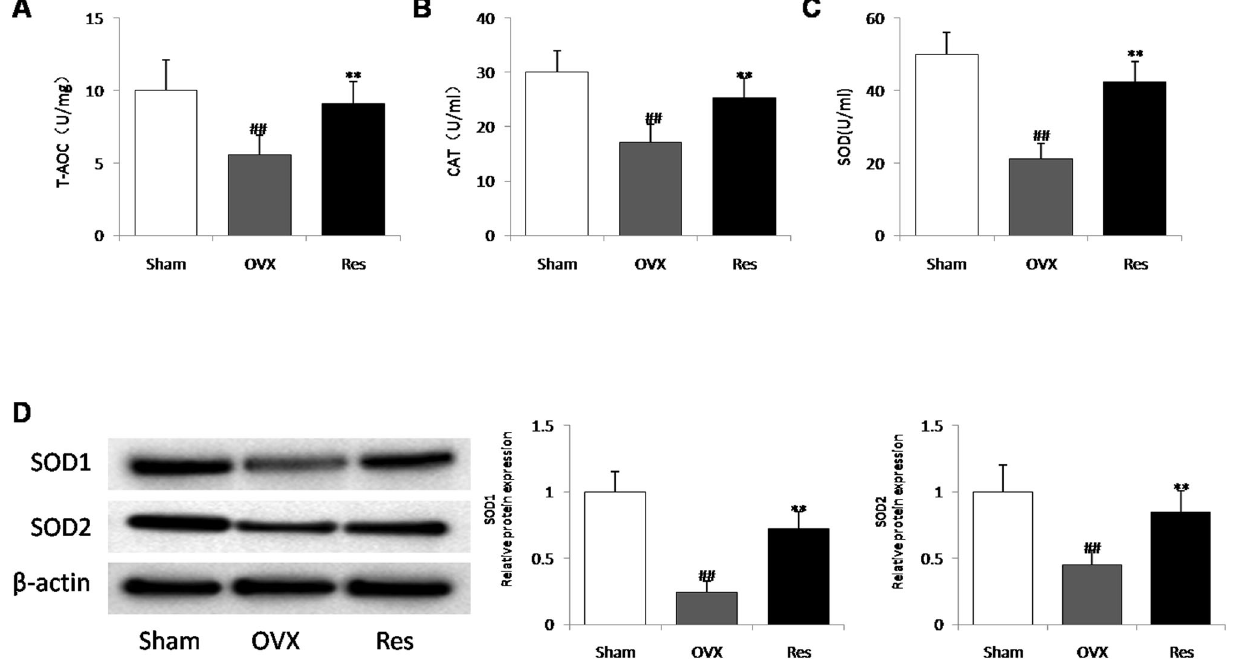
Fig. 6 Effects of resveratrol on oxidative stress status in the ovariectomized model. A – C total antioxidant capacity (T-AOC) ( A ), catalase (CAT) ( B ), and superoxide dismutase (SOD) ( C ) activity in proximal tibias. ( D ) The protein expression levels of SOD1 and SOD2 were detected by western blot. Data were the means ± SD ( n = 6 for each group). ## P < 0.01 vs . Sham group; ** P < 0.01 vs. OVX